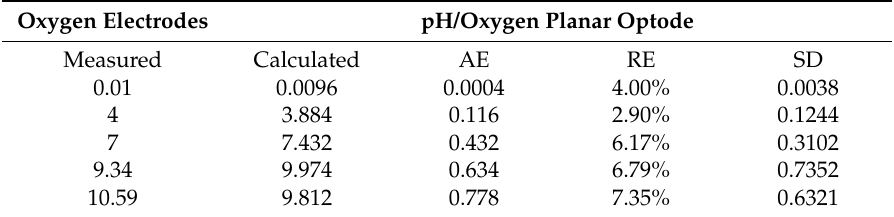
Table 1. Comparison of the pH/Oxygen planar optode and electrodes for oxygen measurements. AE: absolute error; RE: relative error; SD: standard deviation.